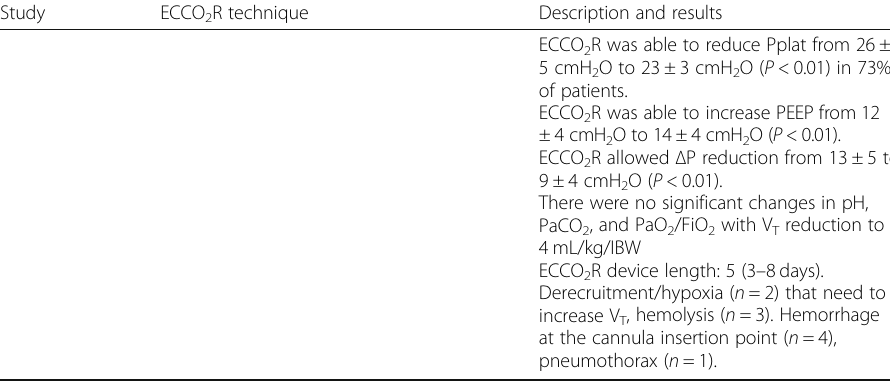
Table 4 Relevant clinical studies of ECCO 2 R in ARDS patients (Continued)